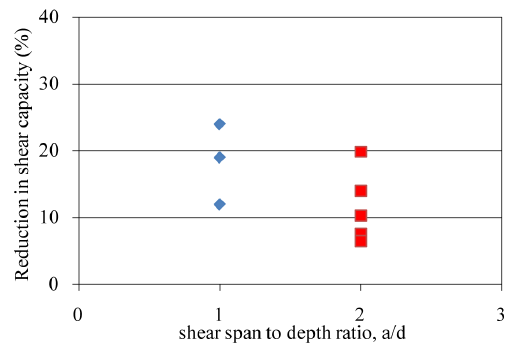
Fig. 13. Variation of reduction in shear capacity with stirrup spacing